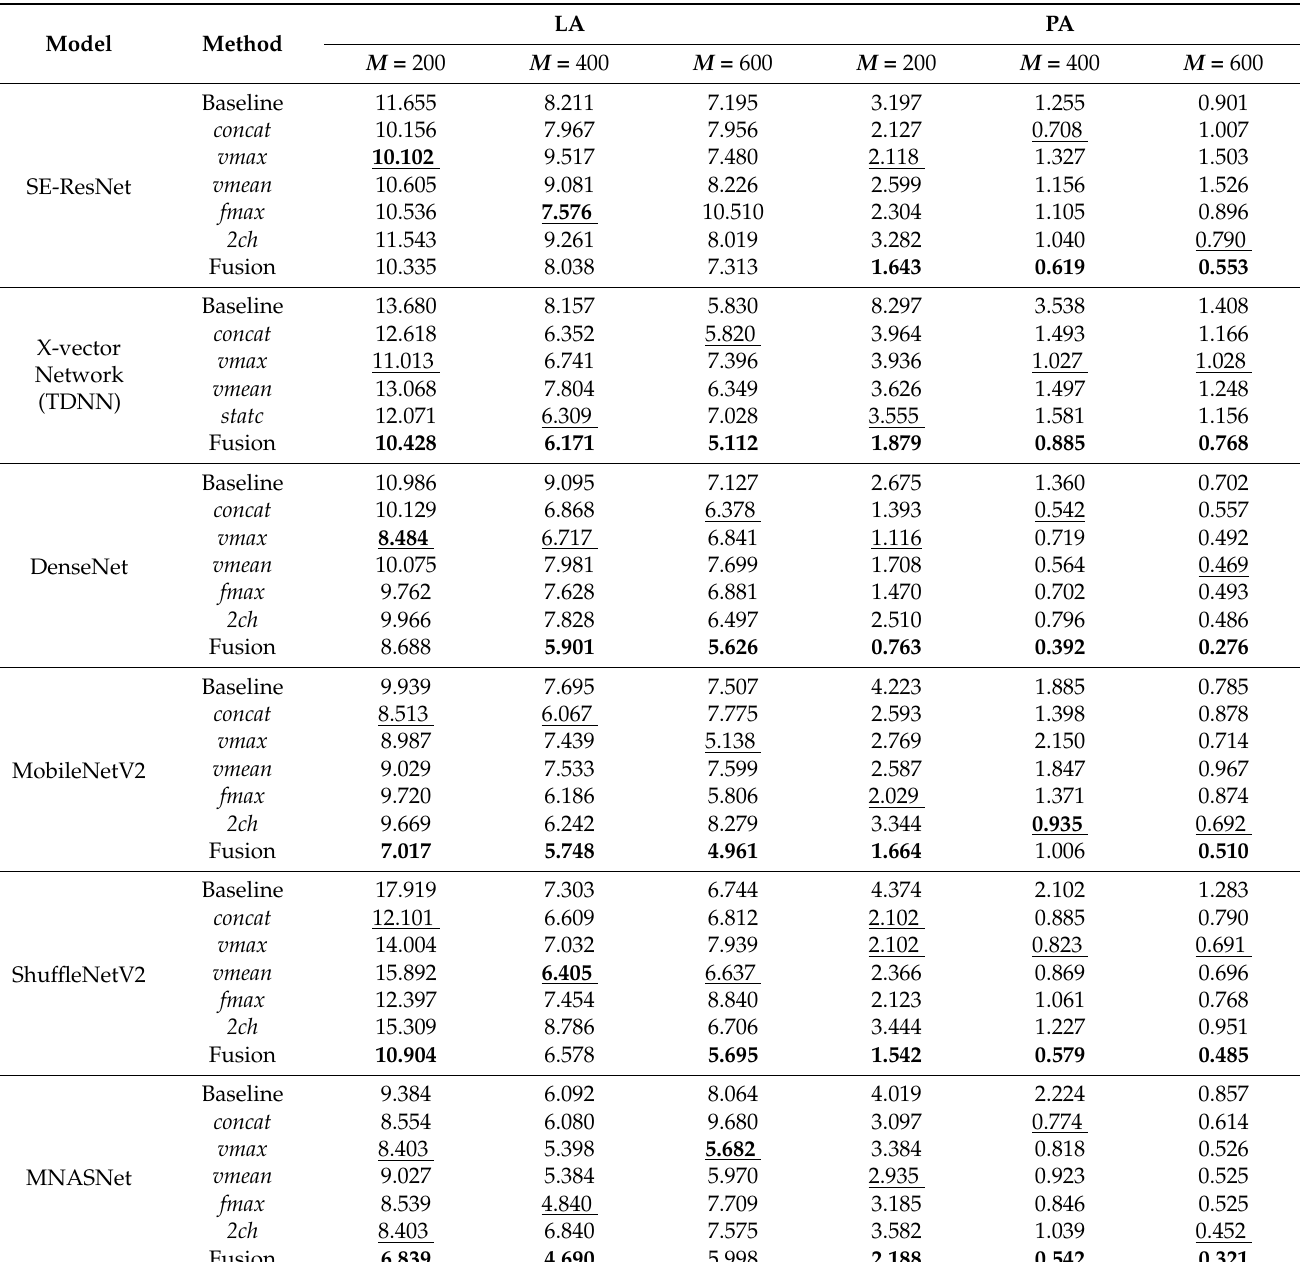
Table A1. Oracle EERs (%) of systems on the evaluation trials of ASVspoof 2019 LA and PA scenarios. For each model, the lowest EER is highlighted in bold (comparison including Fusion ) or is underlined (comparison excluding Fusion